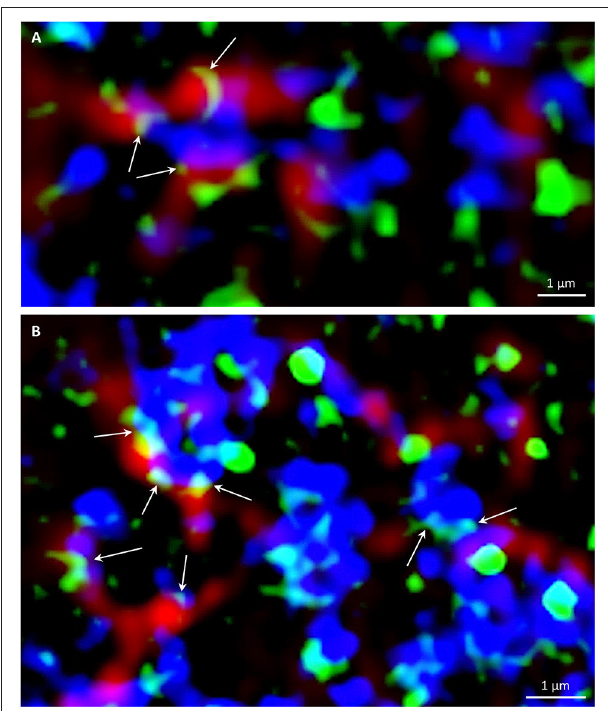
FIGURE 11 | Super-resolved SIM immunofluorescence colocalization of cortical microtubules (red), PLD α 1–YFP (green) and clathrin (blue) in Arabidopsis root cells of complemented pld α 1-1 mutant expressing PLD α 1–YFP. Arrows indicate spot-like and ring-like structures of PLD α 1–YFP in close contact with cortical microtubules and individual CCVs and CCPs (A) , or CCVs and CCPs arranged in clusters (B)